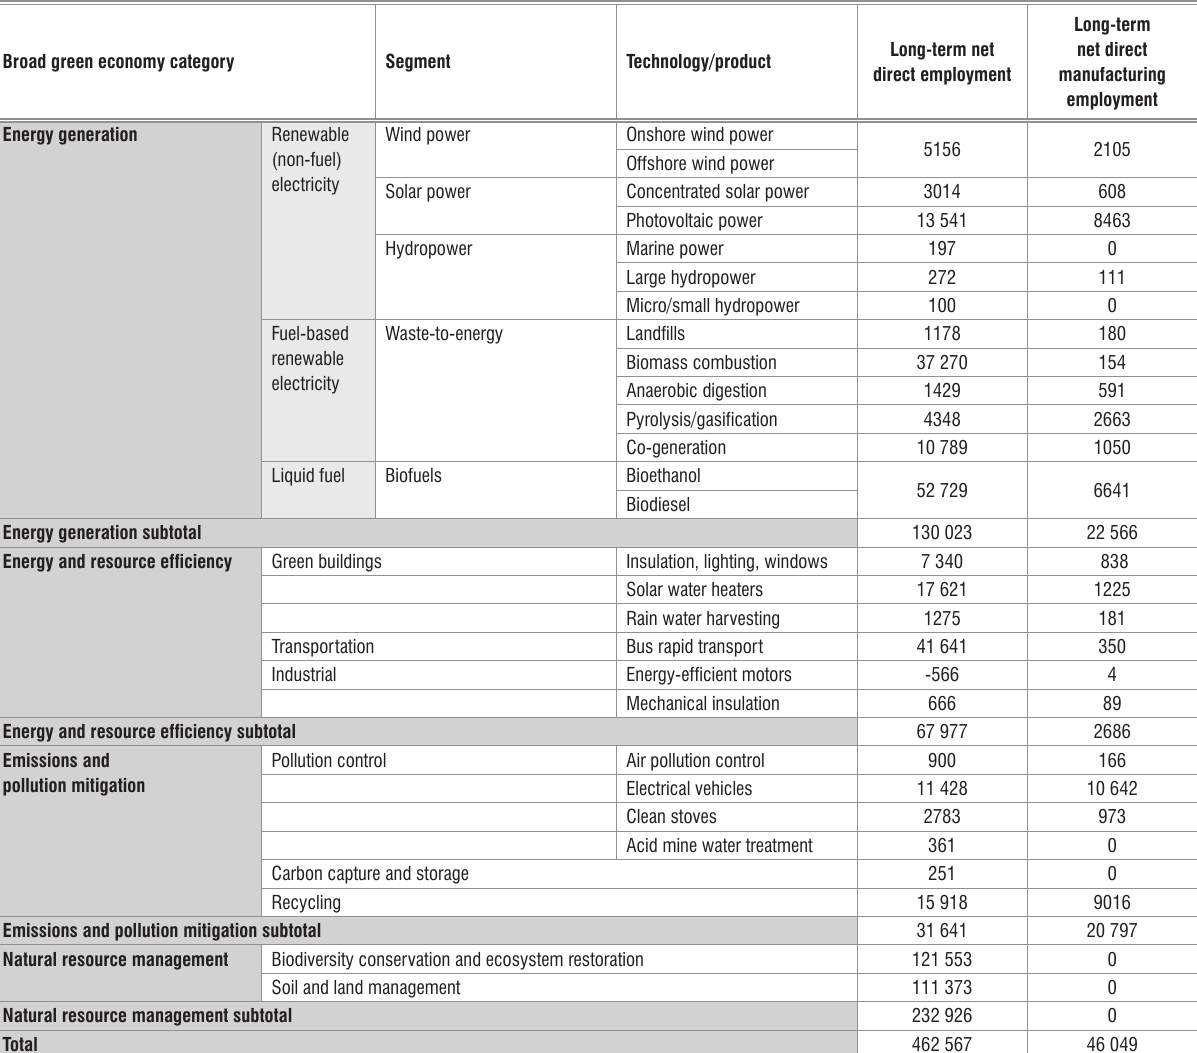
Table 1: Employment estimates by green economy categories and segments